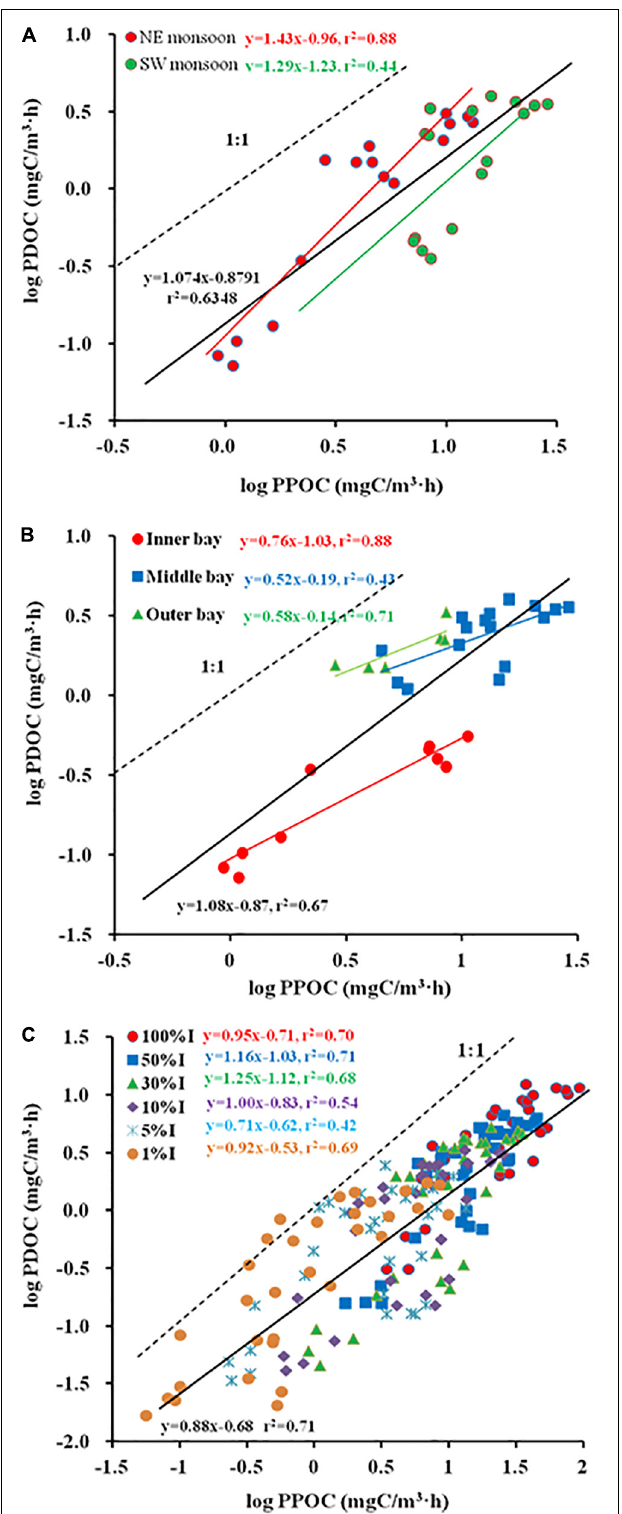
FIGURE 4 | Regression plots of Log (particulate organic carbon (PPOC)) vs. Log (photosynthetic dissolved organic carbon (PDOC)) [ (A) season, (B) sector, (C) Z eu ].